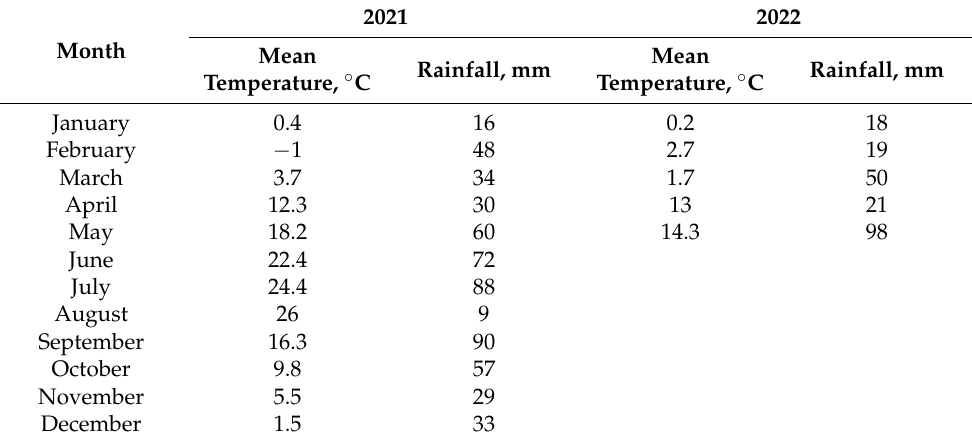
Table 5. Mean month temperature and rainfall during the